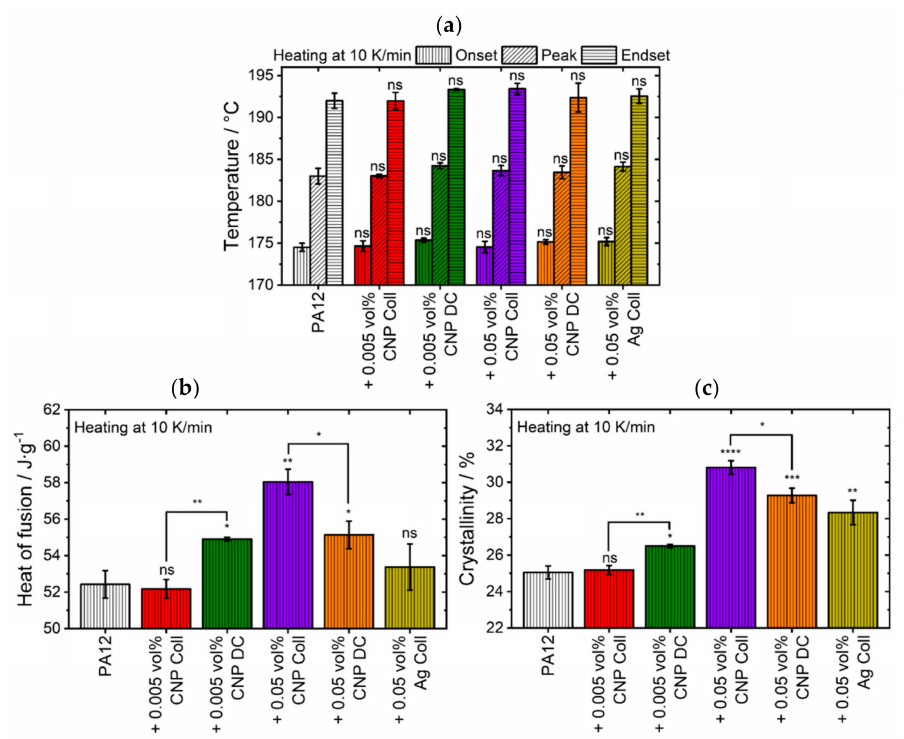
Figure 3. Averaged thermal values of different material compositions showing their results of ( a ) peak melting temperature values, ( b ) heat of fusion, and ( c ) crystallinity. The level of significance increases with the number of asterisks, while “ns” stands for an insignificant